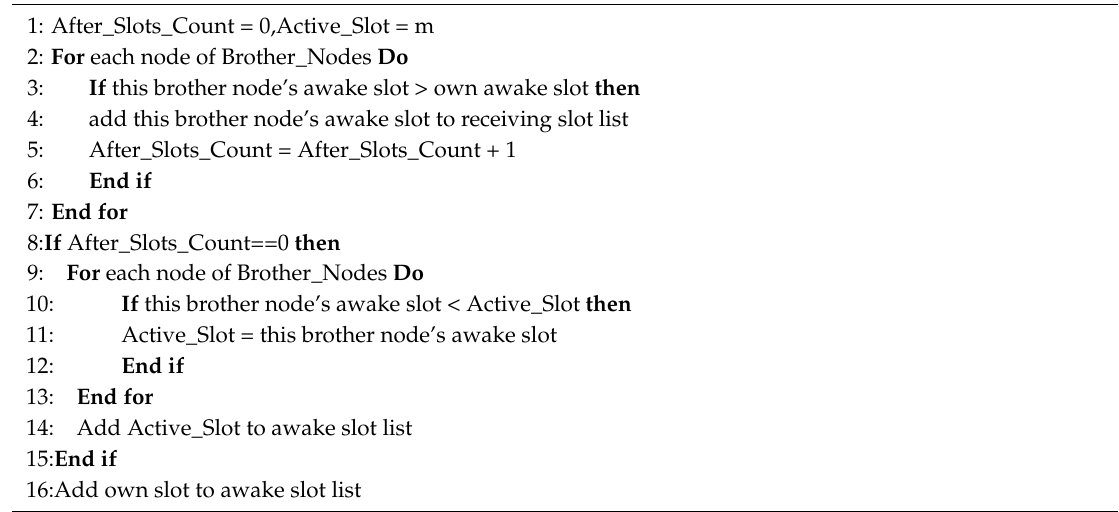
Algorithm 6 Initialize son nodes under BTAS scheme